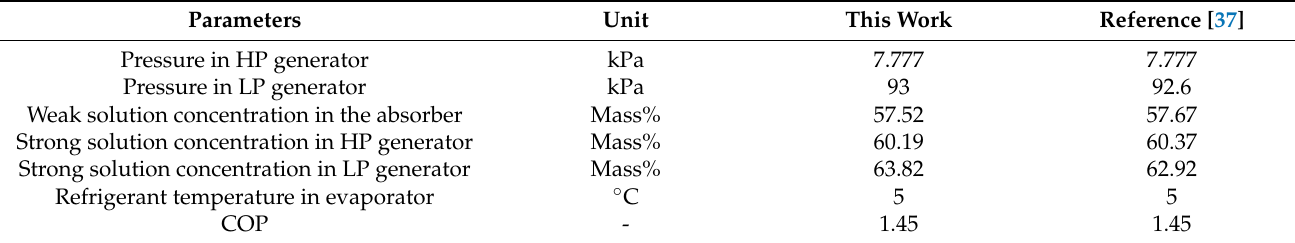
Table 3. Operating and design parameters for